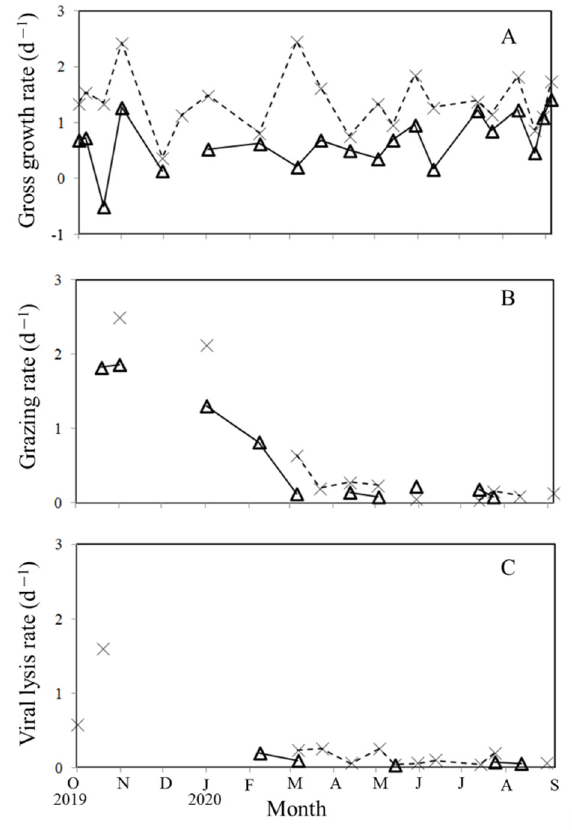
Figure 5. Seasonal variations of Synechococcus spp. ( ∆ ) and picoeukaryotic ( × ) gross growth rates ( A ), grazing mortality ( B ), and viral lysis mortality rates ( C ).